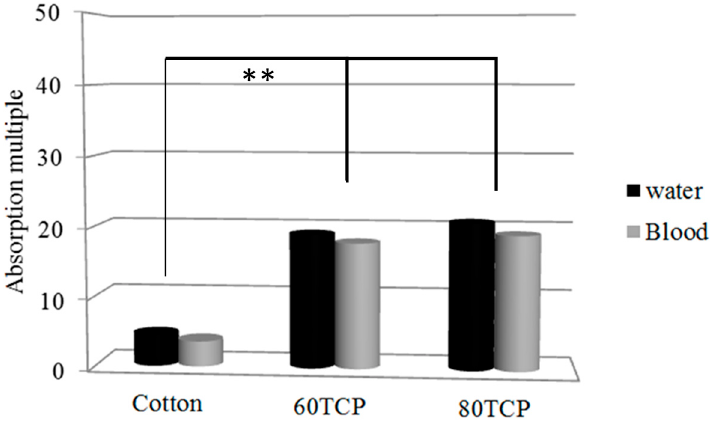
Figure 6. Water and blood absorptions of cotton cloth and TCP nonwovens with 60 wt % and 80 wt % Tencel ® fibers. ** p < 0.01.